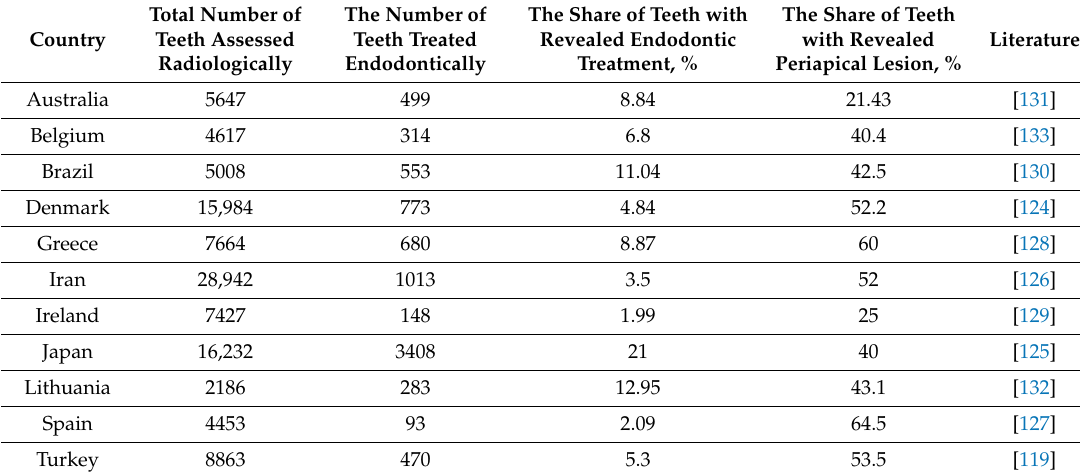
Table 5. Selected epidemiological data on the number of teeth treated endodontically with periapical lesions revealed in pantomographic